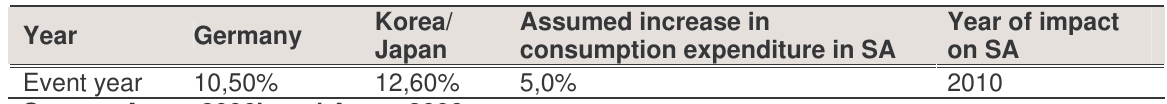
Table 1: Estimated Impact on International Visitation based on Previous SWC Experiences